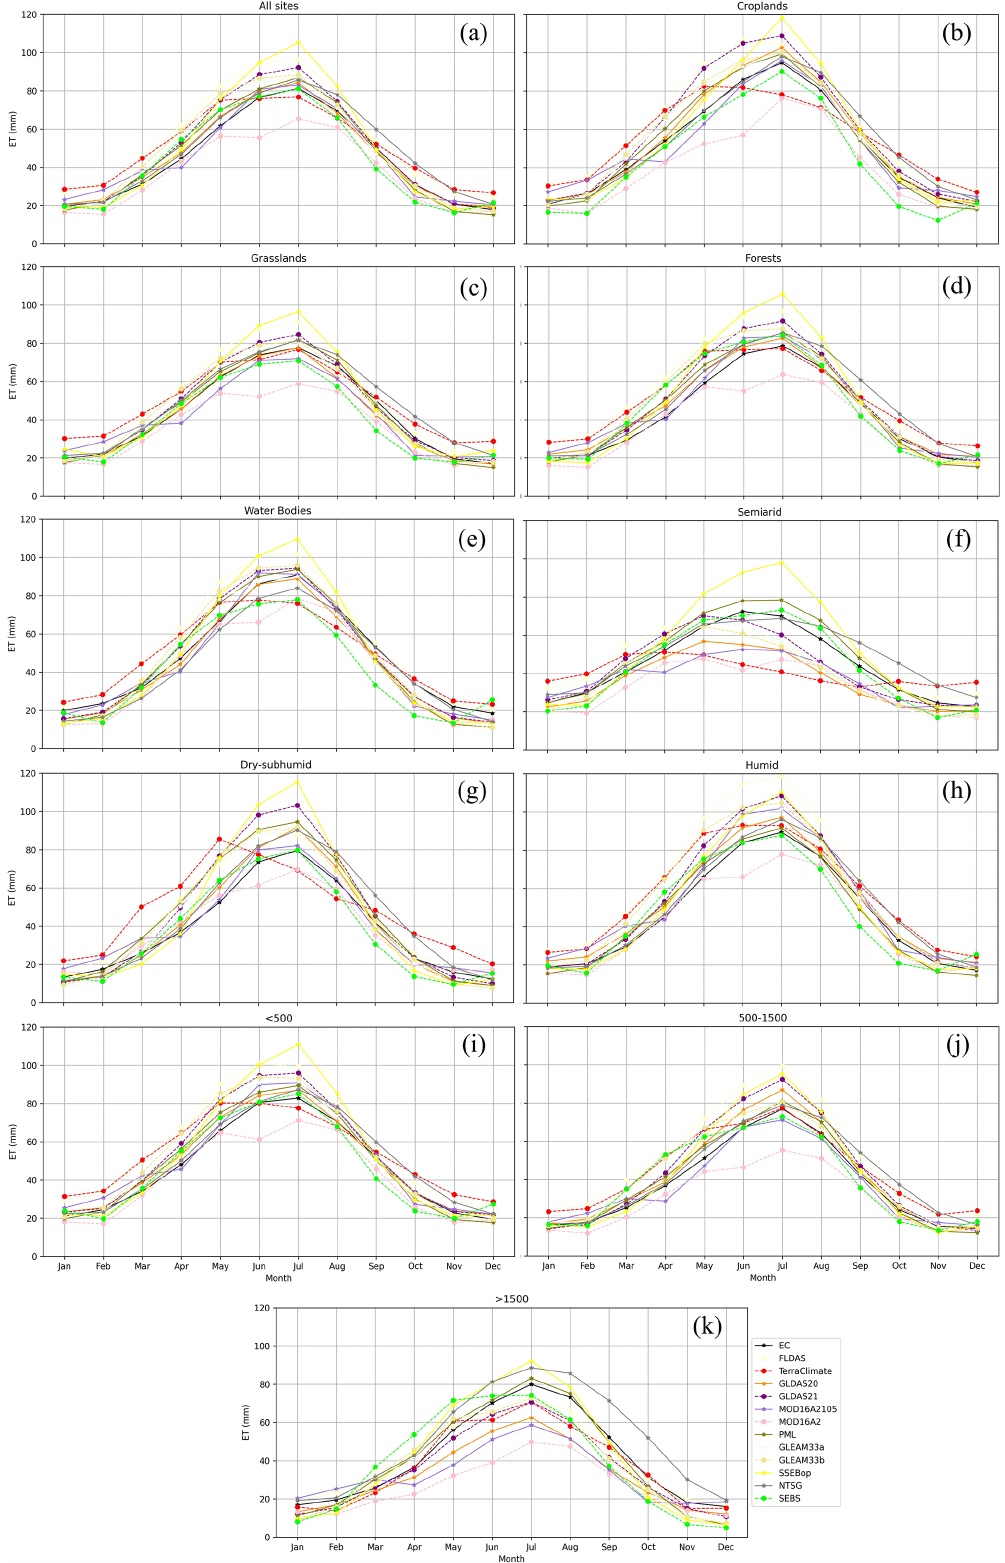
Figure 3. Monthly average flux EC ET and 12 ET products over all flux sites (a) , land cover types (croplands: b ; grasslands: c ; forests: d ; water bodies: e ), climate classes (semiarid: f ; dry subhumid: g ; humid: h ), and elevation levels ( < 500m: i ; 500–1500m: j ; > 1500m: k ). https://doi.org/10.5194/essd-13-447-2021 Earth Syst. Sci. Data, 13, 447–480,